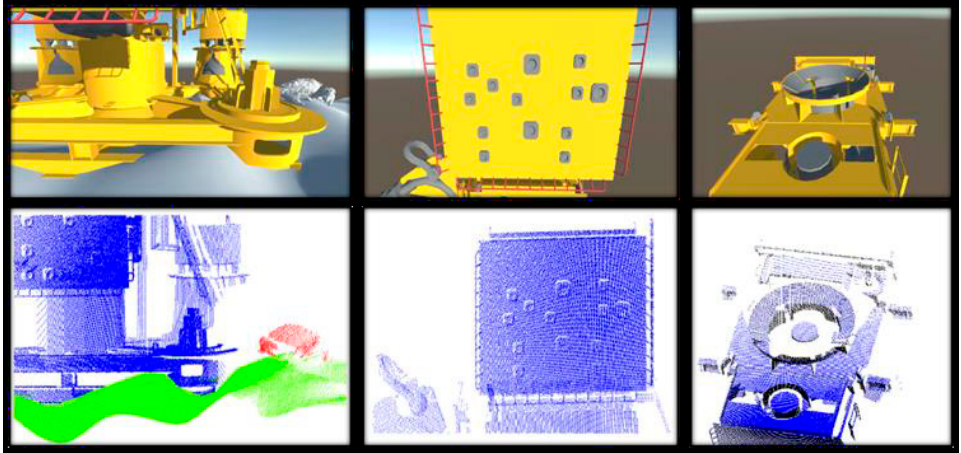
Figure 5. Comparison between virtual scene module camera preview and each synthetic point cloud generated per sensor scanning position [29].